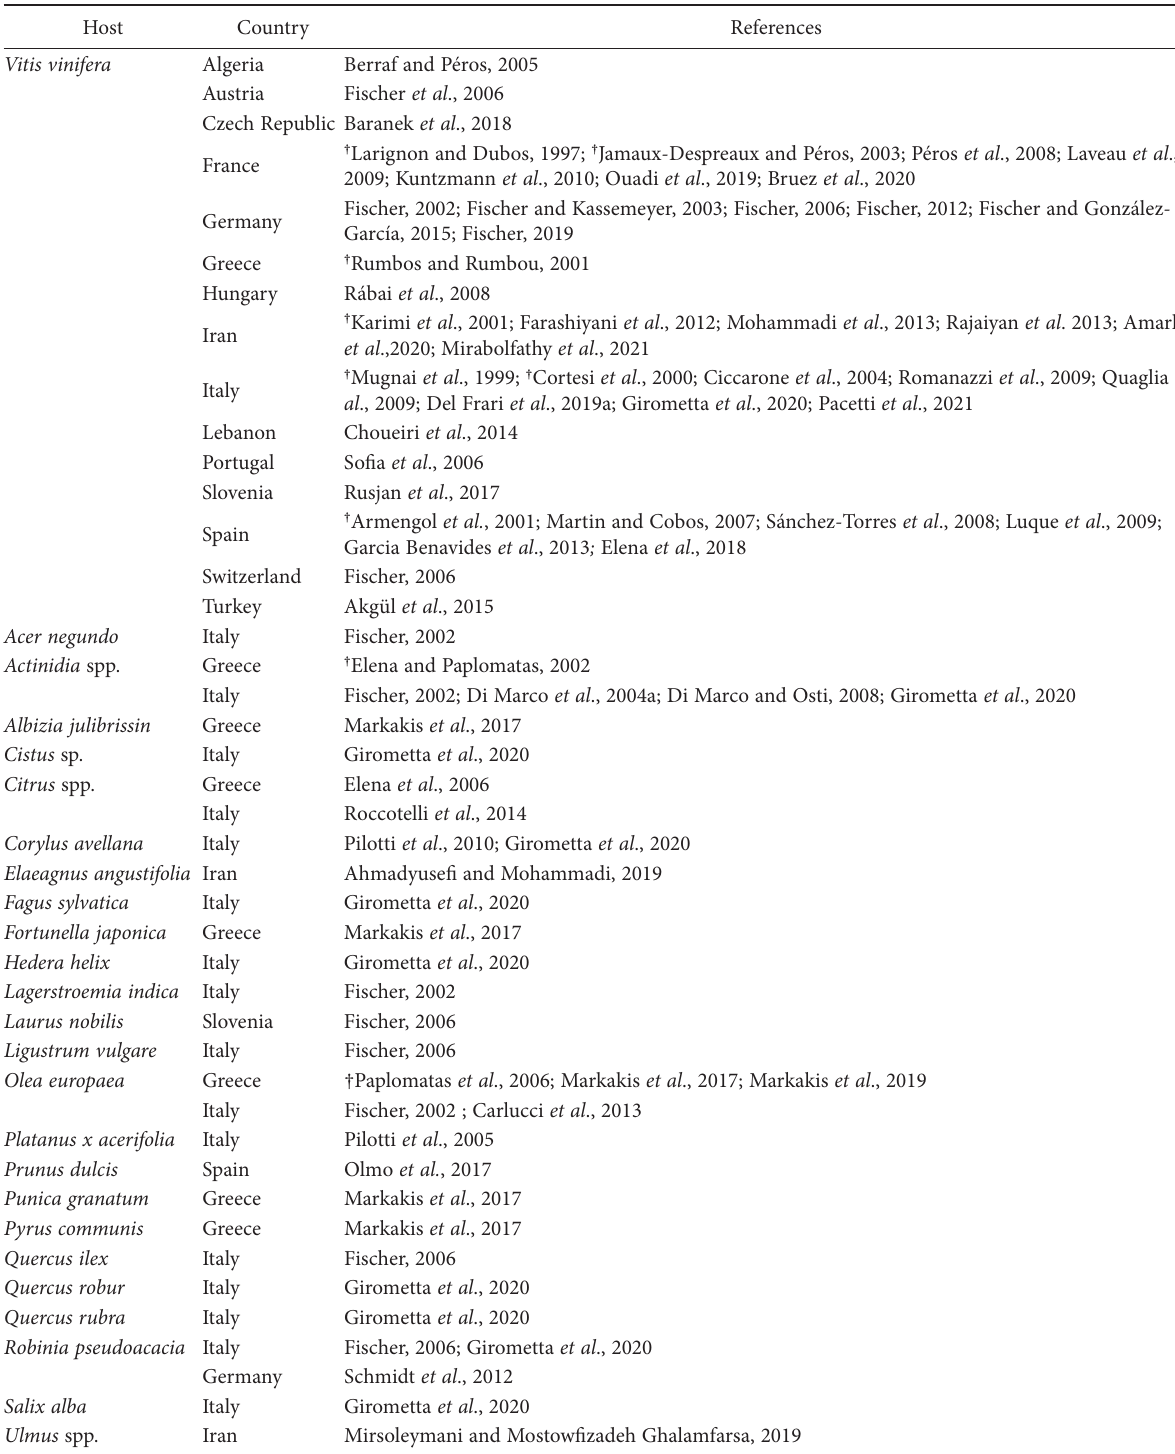
Table 1. Host range and geographic distribution of Fomitiporia mediterranea M. Fischer 2002. For each host (and each country), the table includes first reports which used classical isolations, and some of the significant subsequent reports/studies which used molecular classifica- tion and metagenomic approaches. References accompanied by “†” refer to studies which used former classifications (as Phellinus punctatus or F. punctata ) which should be carefully reconsidered as representing F. mediterranea